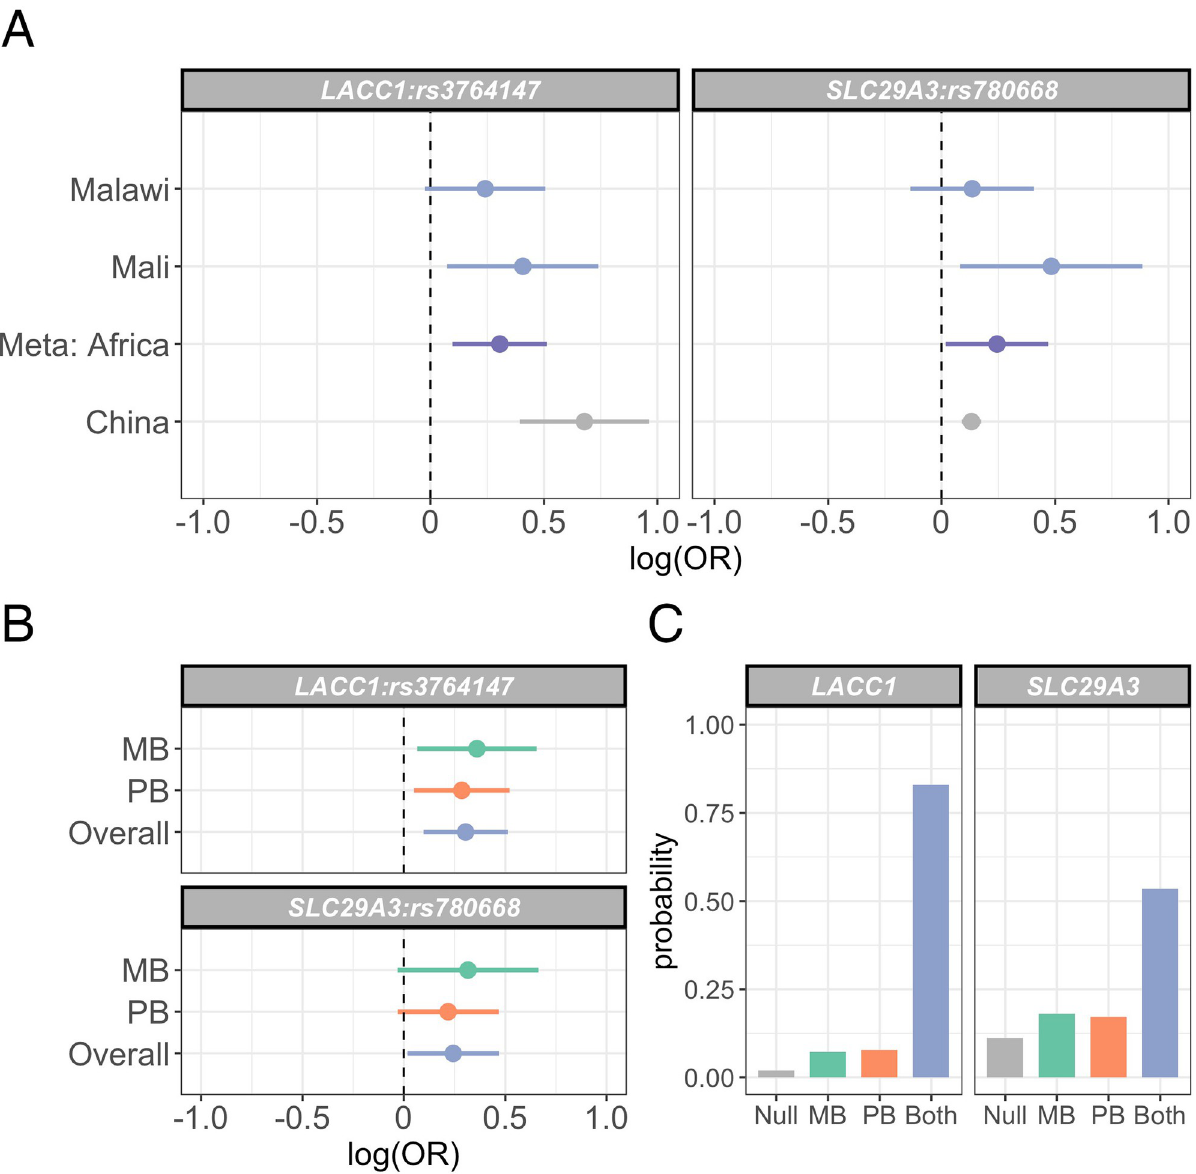
Fig 5. Replication of leprosy associations at LACC1 and SLC29A3 in Malawi and Mali. (A) Log-transformed odds ratios and 95% confidence intervals of rs3764147 and rs780668 associations with leprosy in Malawi and Mali. (B) Log-transformed odds ratios and 95% confidence intervals of rs3764147 and rs780668 associations with leprosy stratified by multibacillary and paucibacillary disease. (C) Posterior probabilities of models of rs3764147 and rs780668 associations with leprosy: “Null”, no association with leprosy; “MB”, non-zero effect in multibacillary leprosy alone; “PB”, non- zero effect in paucibacillary leprosy alone; “Both”, the same non-zero effect is shared by individuals with multibacillary and paucibacillary leprosy.